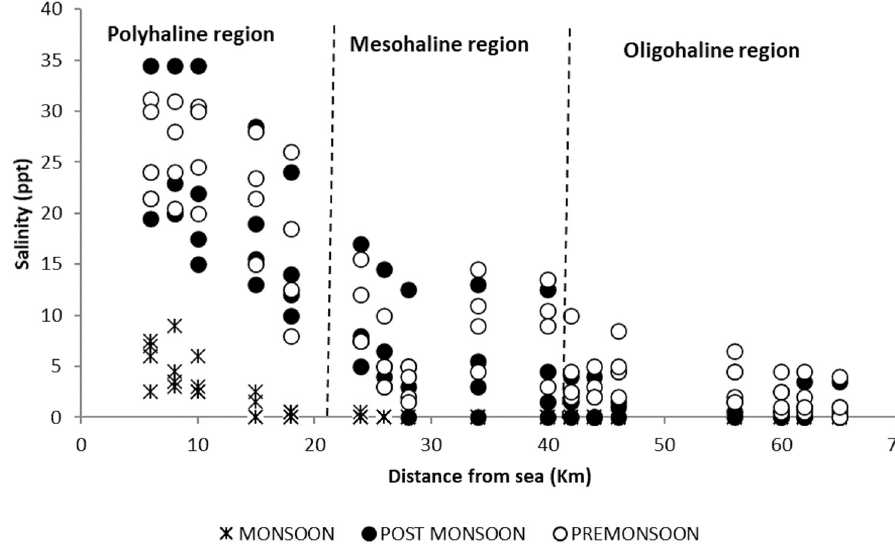
Fig. 2. Salinity recorded in various stations of Vembanad lake and their distance from